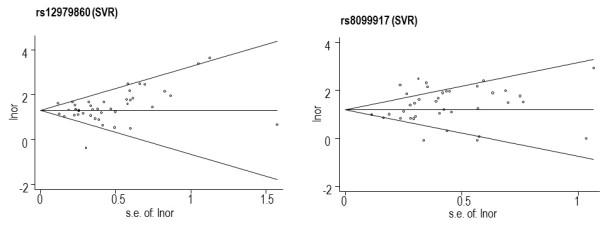
Publication bias. Begg's funnel plots with 95% confidence limits, showing publication bias for rs12979860, rs8099917, and rs12980275 for sustained virologic response (SVR) and rs12979860 for spontaneous clearance (SC).